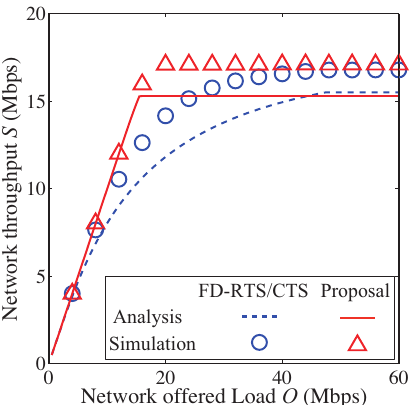
Figure 9. Network throughput as a function of offered load for N = 5.